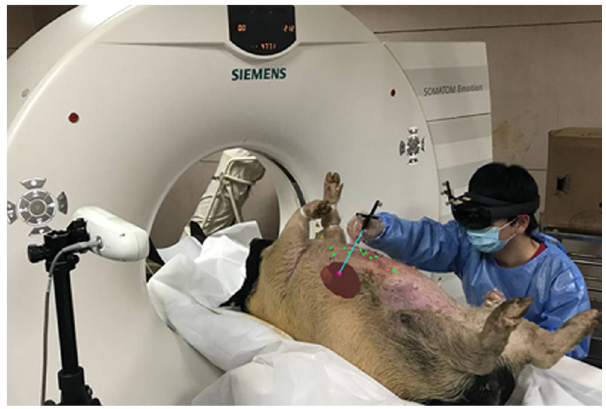
Fig. 8 Mixed reality-navigated needle